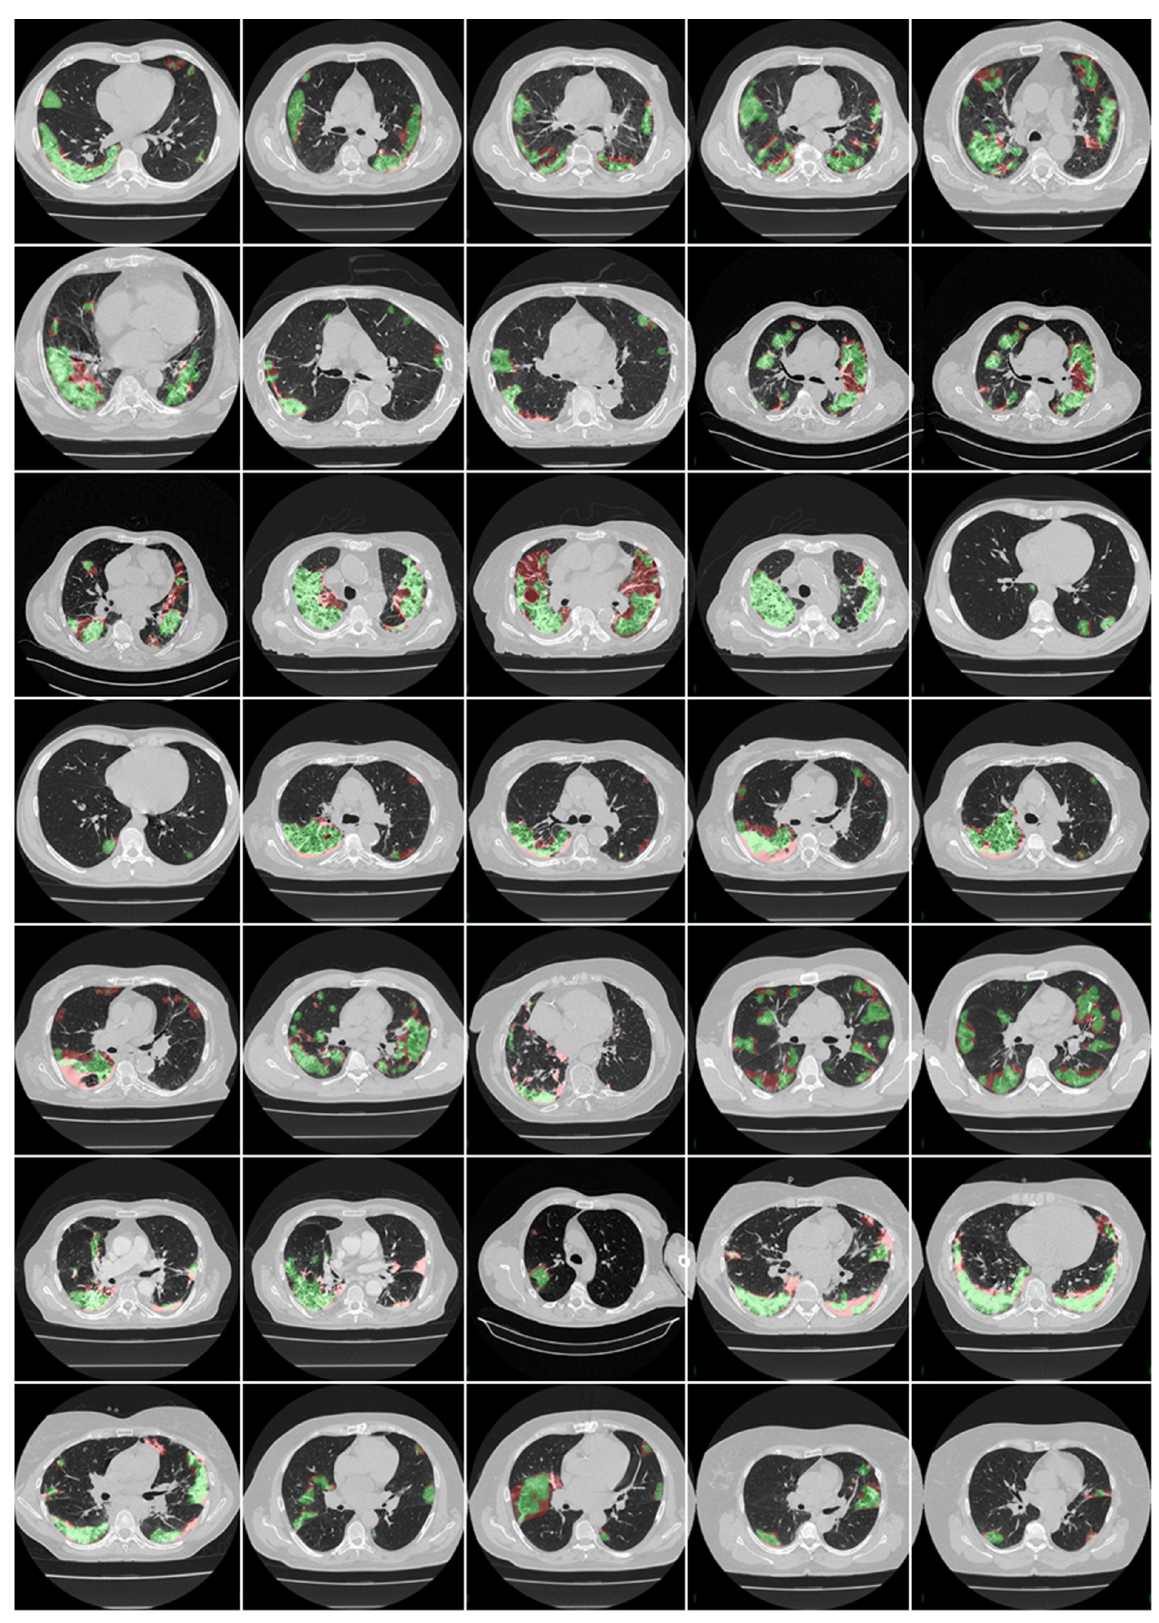
Figure A3. Results of visual lesion overlays showing ResNet ‐ SegNet (green) vs. MD 1 (red).